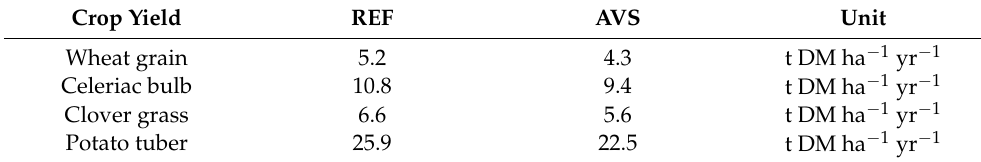
Table 2. Crop yields in the AVS and the reference system per ha.